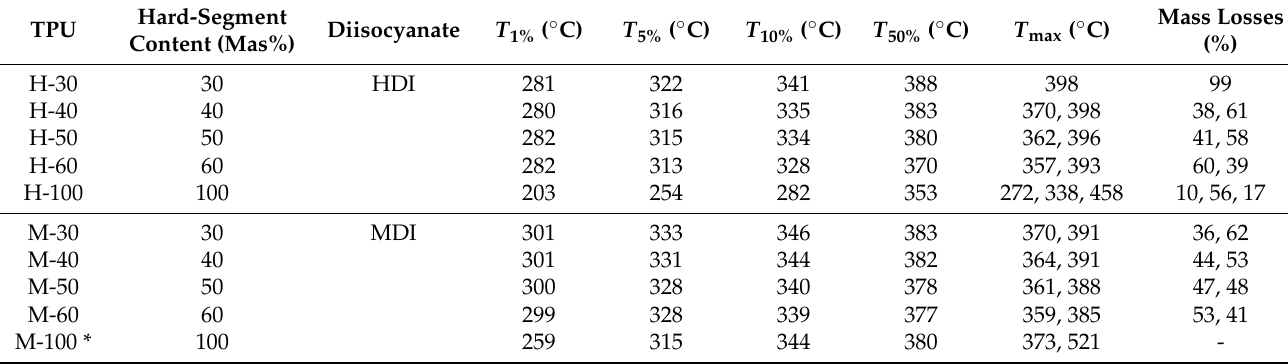
Table 1. Designations and TG-DTG data obtained for TPUs in the helium atmosphere.